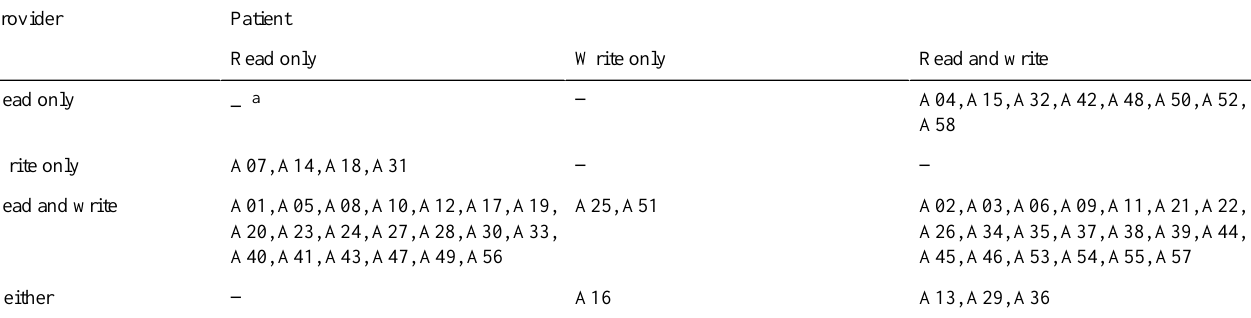
Table 5. Matrix of various read and write models among the blockchain personal health records reviewed.